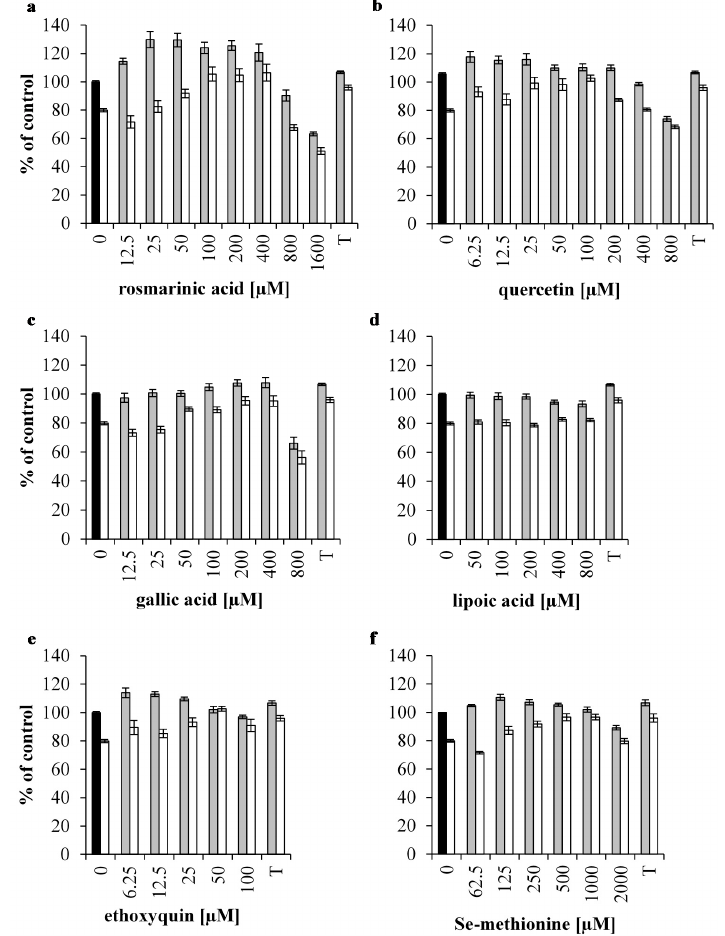
Figure 1. Viability of H 2 O 2 treated intestinal porcine epithelial cells (IPEC-J2) pre-treated with antioxidants. Viability of IPEC-J2 cells is presented as a percentage of the untreated control cells ( black bar: untreated control cells, grey bars: no incubation with oxidative stress; white bars: cells stressed by 1 mM H 2 O 2 ) after treatment with ( a ) rosmarinic acid (RA), ( b ) quercetin (Que), ( c ) gallic acid (GA), ( d ) lipoic acid (LA), ( e ) ethoxyquin (ETQ) and ( f ) selenium-methionine (SeMet). All antioxidant pre-treatments were compared with 2 mM Trolox (T). Results are presented as means ± S.E., n = 2.